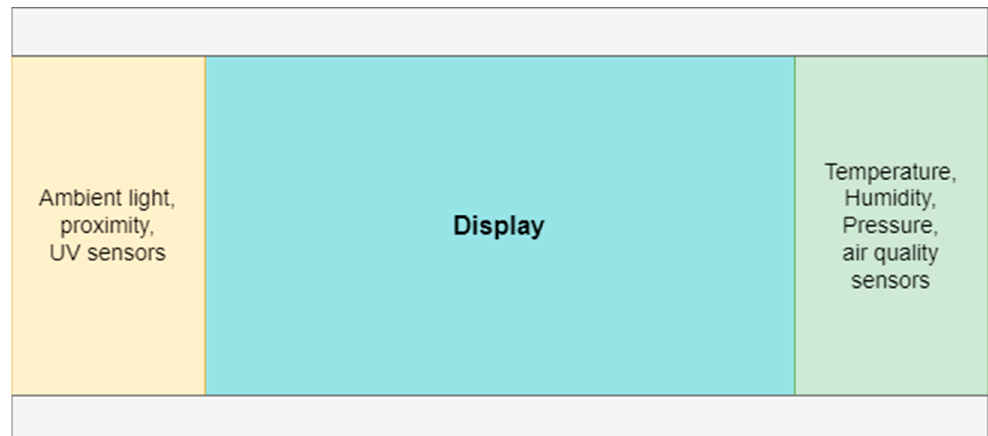
Figure 5. Display and sensor box arrangement.